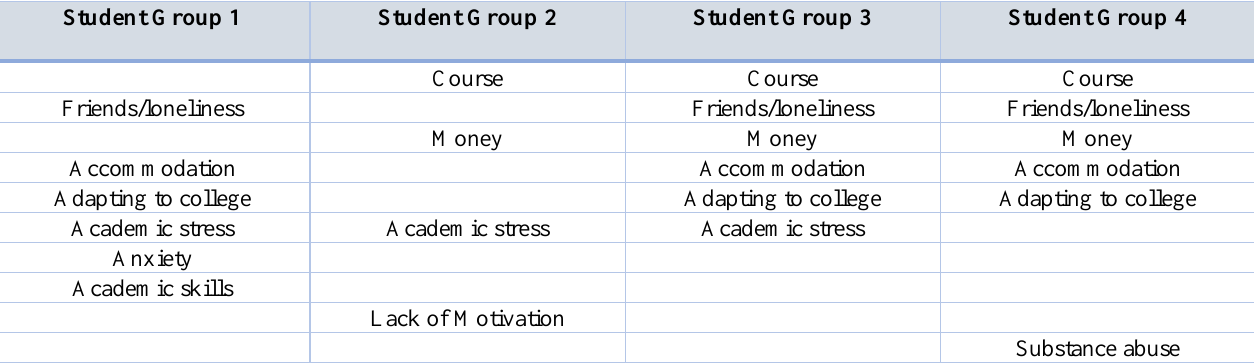
The Ten Key Barriers to First-Year Student